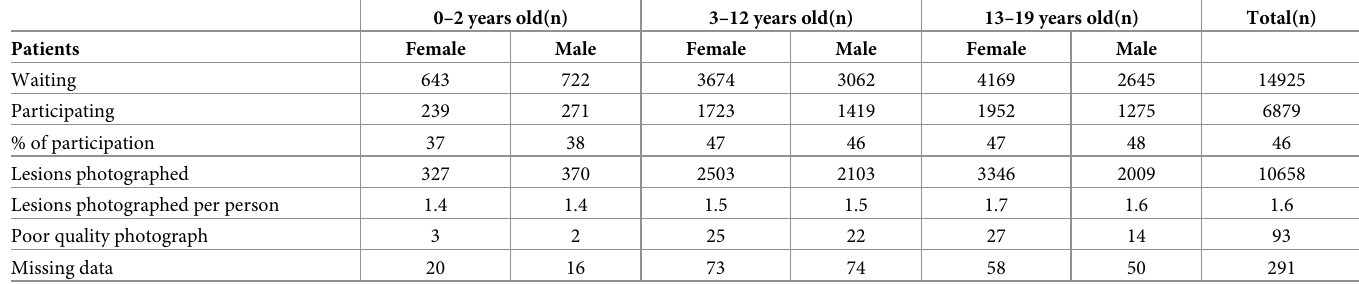
Table 1. Number of lesions photographed and individuals from 0 to 19 years old waiting for a dermatologist consultation and those who participated in the Tele- dermatology project, according to age and sex, from July 2017-July 2018, in the city of S ã o Paulo.